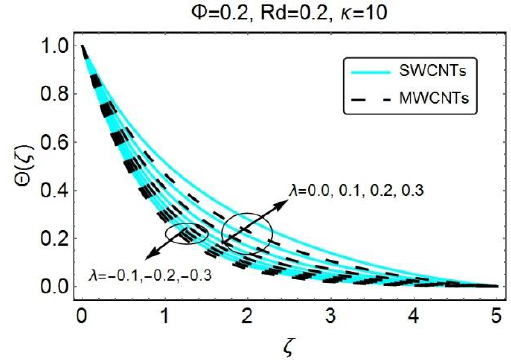
Figure 5. Θ(𝜁) for some values of 𝜆.